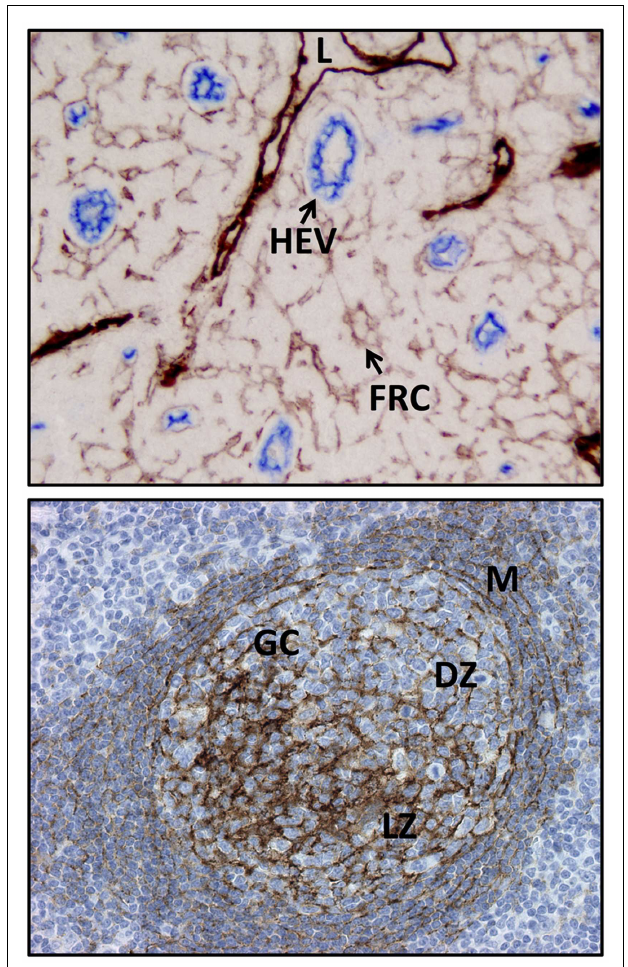
FIGURE 2 | Examples of FDC and FRC networks in the human tonsil . Top panel shows the podoplanin positive FRC network and lymphatic vessels (both brown) and the surrounding HEV and non-HEV vessels (CD34, blue). Bottom panel shows the FDC network (CD35, brown) in a secondary follicle with a GC. Note light and dark (CD35 positive) regions are readily discerned along with the residual primary follicle or mantle zone surrounding the GC. L, lymphatic vessel; FRC, fibroblastic reticular cell, HEV, high endothelial venule; M, mantle zone or primary follicle;